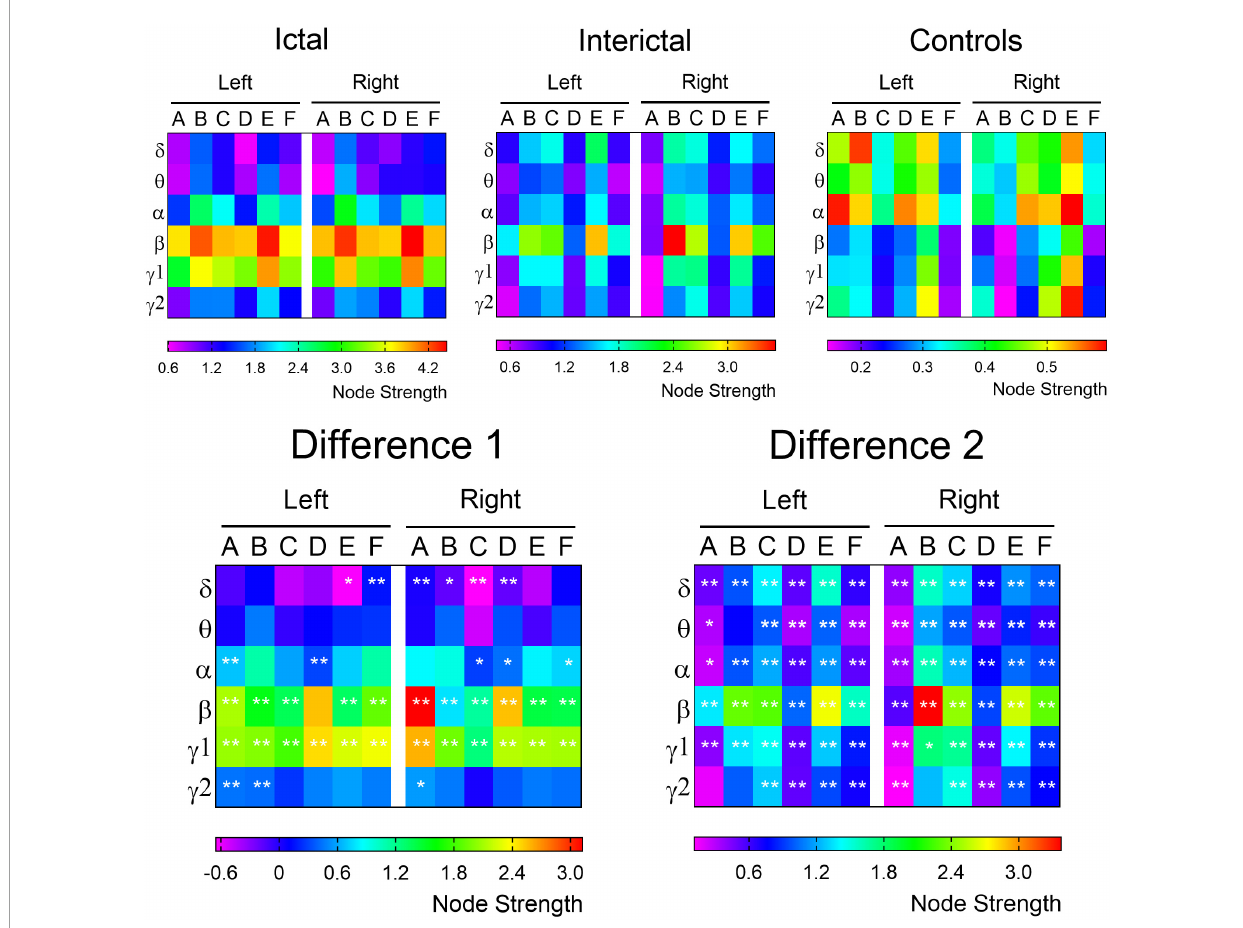
FIGURE4 The node strength of each ROI within the DMN. The node strength of each ROI from the delta to gamma 2 bands is color-coded for control, ictal and interictal data, respectively. The difference 1 (ictal minus interictal) and difference 2 (interictal minus control) of the node strength demonstrate the alterations in functional connectivity. A, IPL; B, MFC; C, MTL; D, PCu; E, PCC; F, LTL. * p < 0.05; ** p < 0.01.